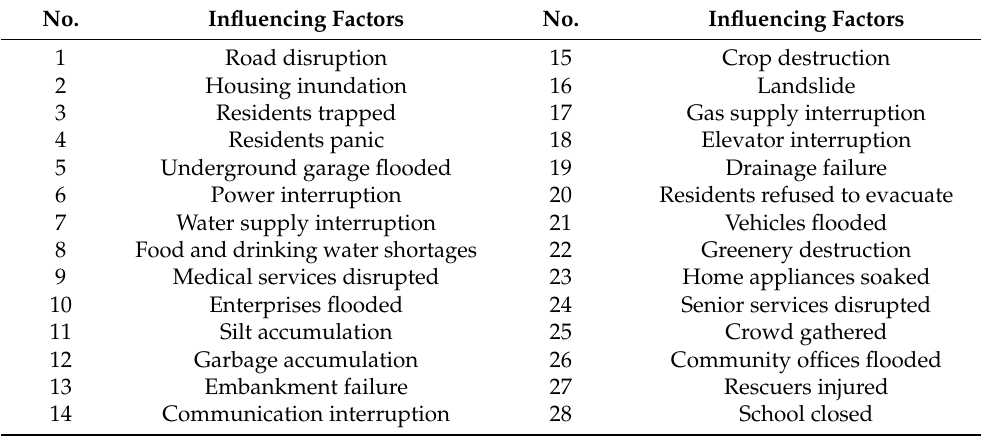
Table 2. Influencing factors of urban community function loss in China under flood